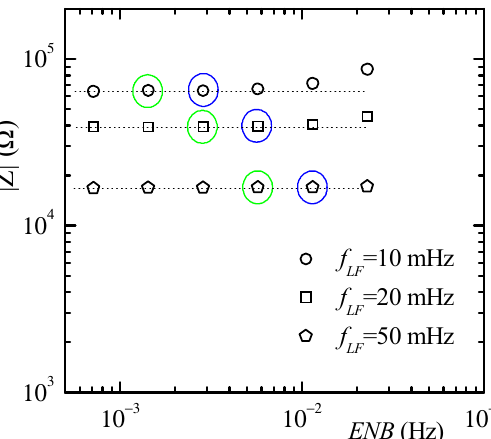
Figure 10. Results of the estimation of the modulus of the impedance of the DUT in Figure 6b as a function of the ENB for the three lowest explored frequencies. It is apparent that if the ENB increases error is introduced because of spectral leakage. The data points used in Figure 9 are encircled in green. It is however apparent that data encircled in blue could have been used without significant error and reduced measurement time.